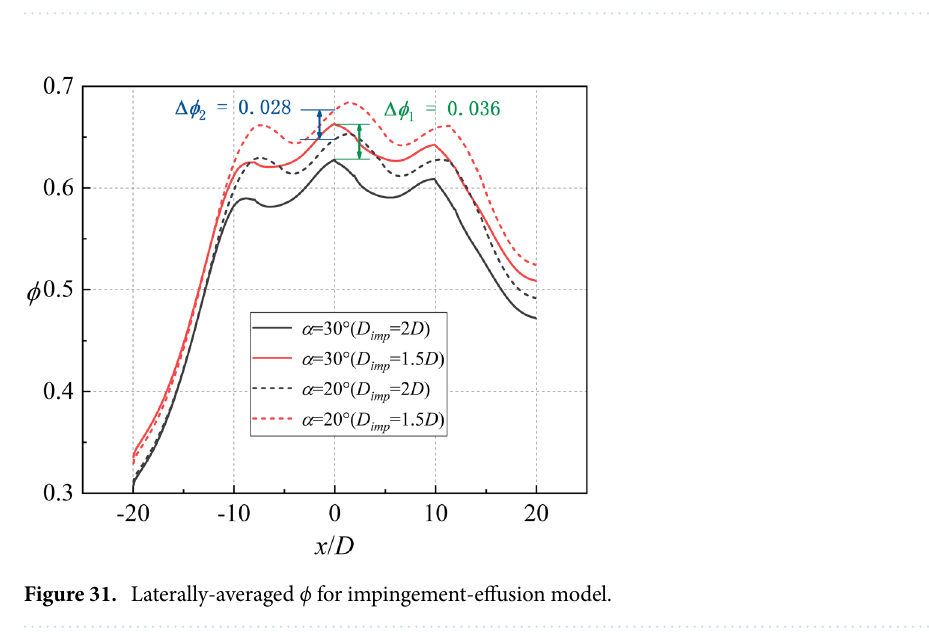
Figure 30. Contours of h g / h i for impingement-effusion model (left: D imp = 2D; right: D imp = 1.5D). ( a ) α = 30°; ( b ) α = 20°.